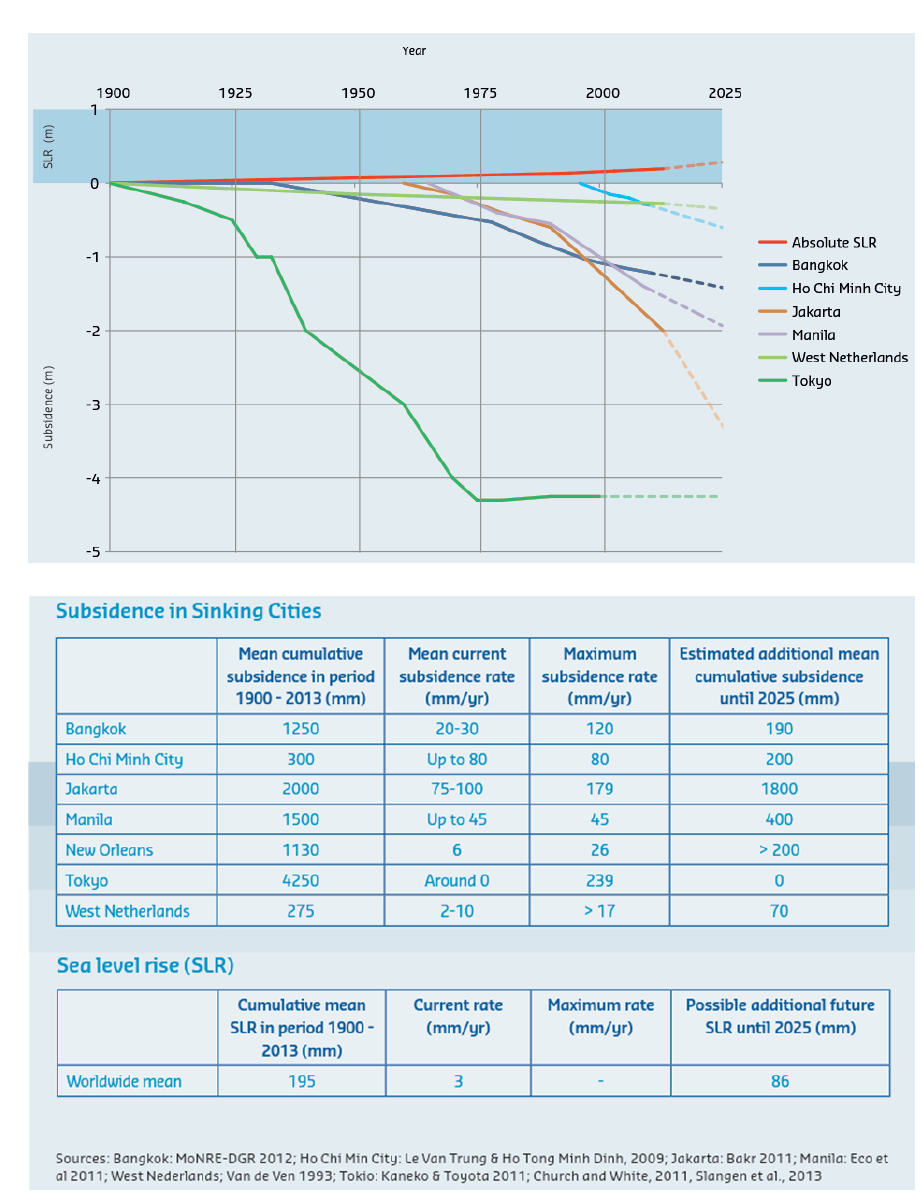
Figure 1. Global sea level rise (SLR) and average land subsidence for several coastal cities (please note that subsidence can differ consider- ably within a city area, depending on groundwater level and subsurface